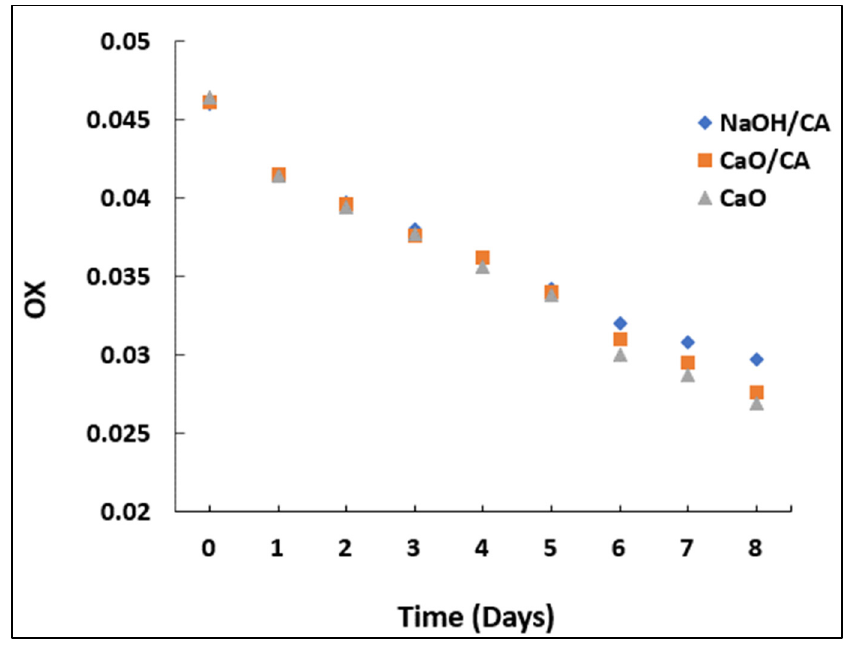
Figure 9. Oxidizability index of B100 under accelerated storage on different days.